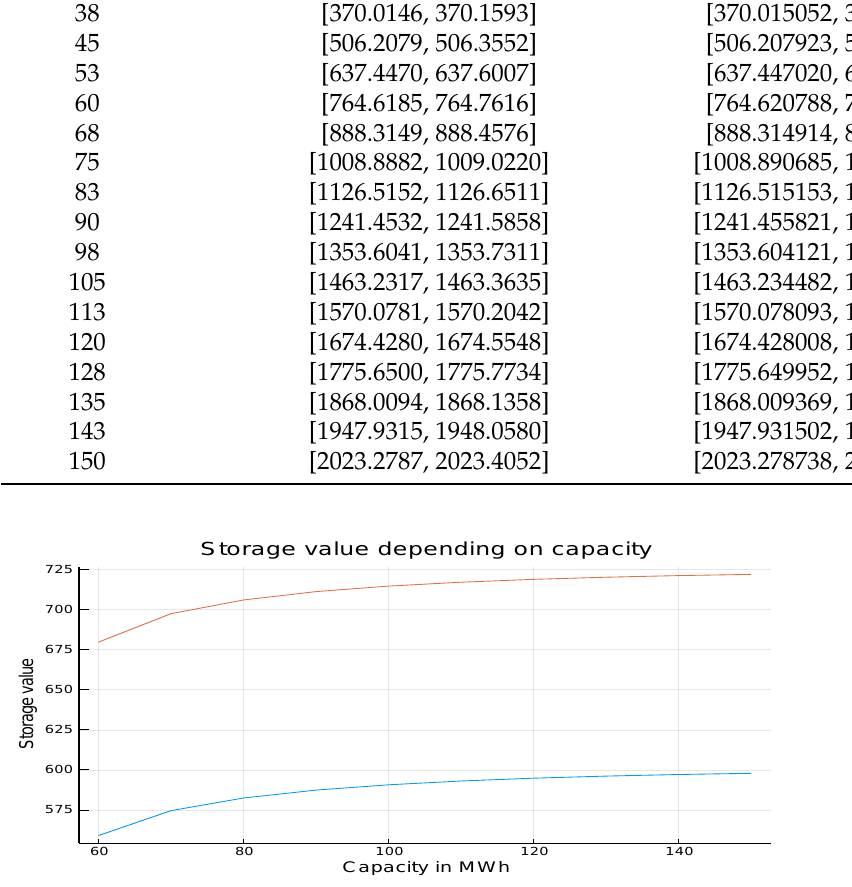
Figure 7. Initial value of an empty battery at ψ 0 = 10 and for the efficiency parameter κ = 0.97 ( lower line ) and κ = 1.0 ( upper line